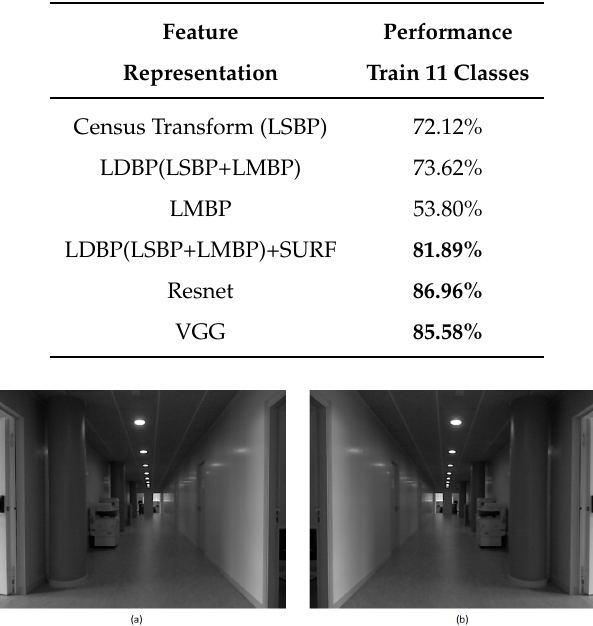
Figure 5. Original test image on the left, and new test image, obtained from the original one by mirror reflection, on the